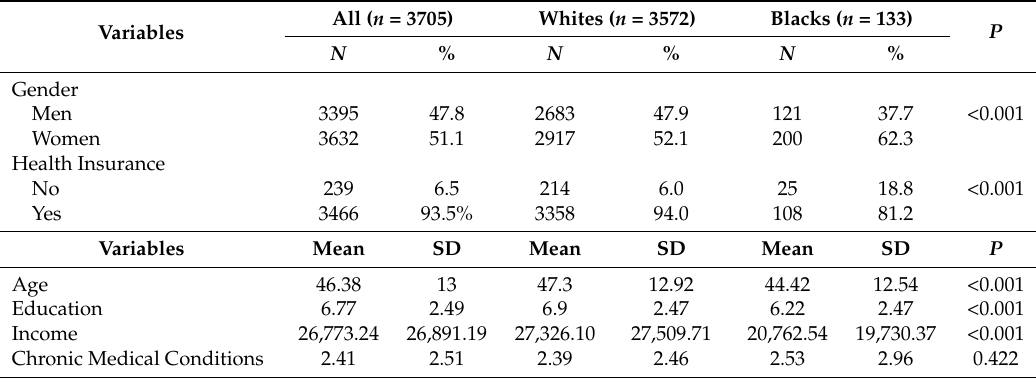
Table 1. Descriptive statistics in all and by race.